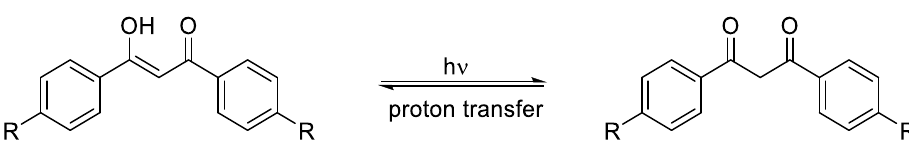
Figure 4. Hydroxybenzophenones energy dissipation through a proton transfer.